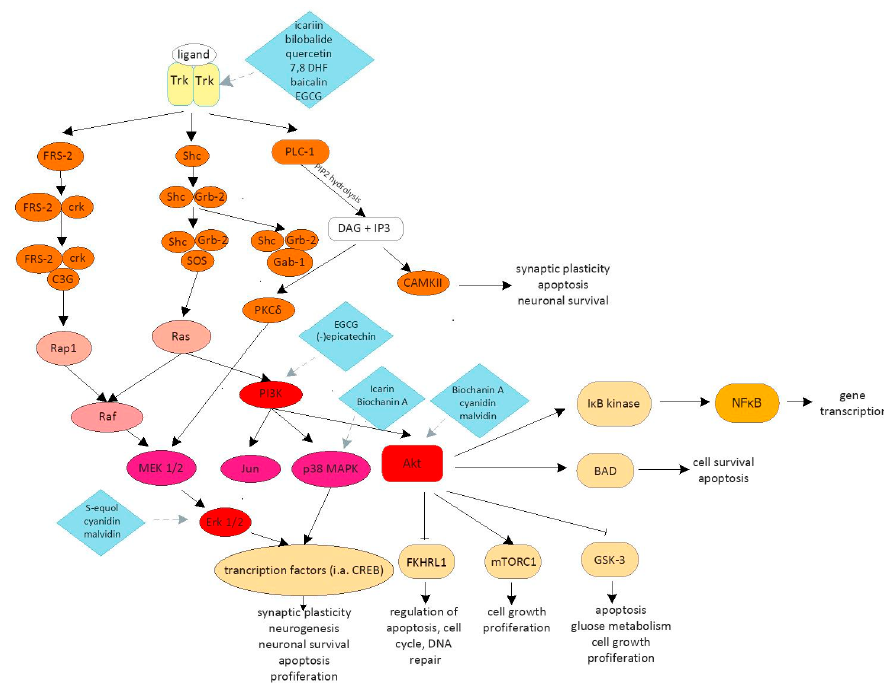
Figure 1. Schematic diagram of the signaling cascades most important in the Figure 1 . Schematic diagram of the signaling cascades most important in the neuroprotection, neuroprotection, proliferation and survival of neurons, including the phospholipase proliferation and survival of neurons, including the phospholipase C/inositol C / inositol trisphosphate / Ca 2 + / calmodulin-dependent protein kinase II (PLC / IP3 / CAMKII), trisphosphate/Ca 2+ /calmodulin-dependent protein kinase II (PLC/IP3/CAMKII), phosphoinositide-3- phosphoinositide-3-kinase–protein kinase B / protein kinase B (PI3K / Akt) and mitogen-activated protein kinase–protein kinase B/protein kinase B (PI3K/Akt) and mitogen-activated protein kinase/extracellular signal-regulated kinase 1/2 (MAPK/Erk) pathways. The activation of these kinase / extracellularsignal-regulatedkinase1 / 2(MAPK / Erk)pathways. Theactivationofthese pathways pathways leads to increased neuronal outgrowth, the inhibition of apoptosis, enhanced leads to increased neuronal outgrowth, the inhibition of apoptosis, enhanced synaptogenesis, as well as synaptogenesis, as well as increased generation of growth factors dependent on neurotrophic factors. increased generation of growth factors dependent on neurotrophic factors. Potential sites of flavonoid interference have been marked on individual signaling pathways. A detailed description with an extension of the abbreviation is included in the